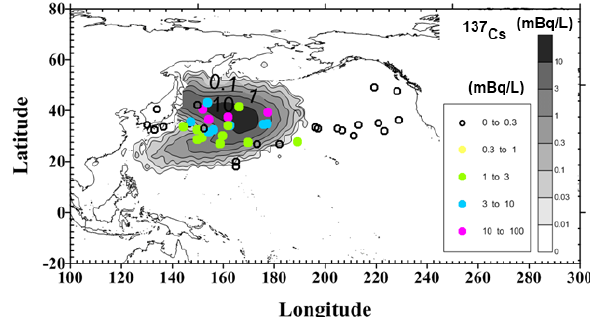
Fig. 7. A comparison of predicted (isolines, calculated using the LAMER code) and measured 137 Cs activity concentrations (dots) in surface water of the NW Pacific Ocean (1mBqL − 1 from the global fallout background was deducted from the measured 137 Cs concentration). The date for the model output was set as 1 March 2012. The experimental 137 Cs data from Aoyama et al. (2013) were from January to March